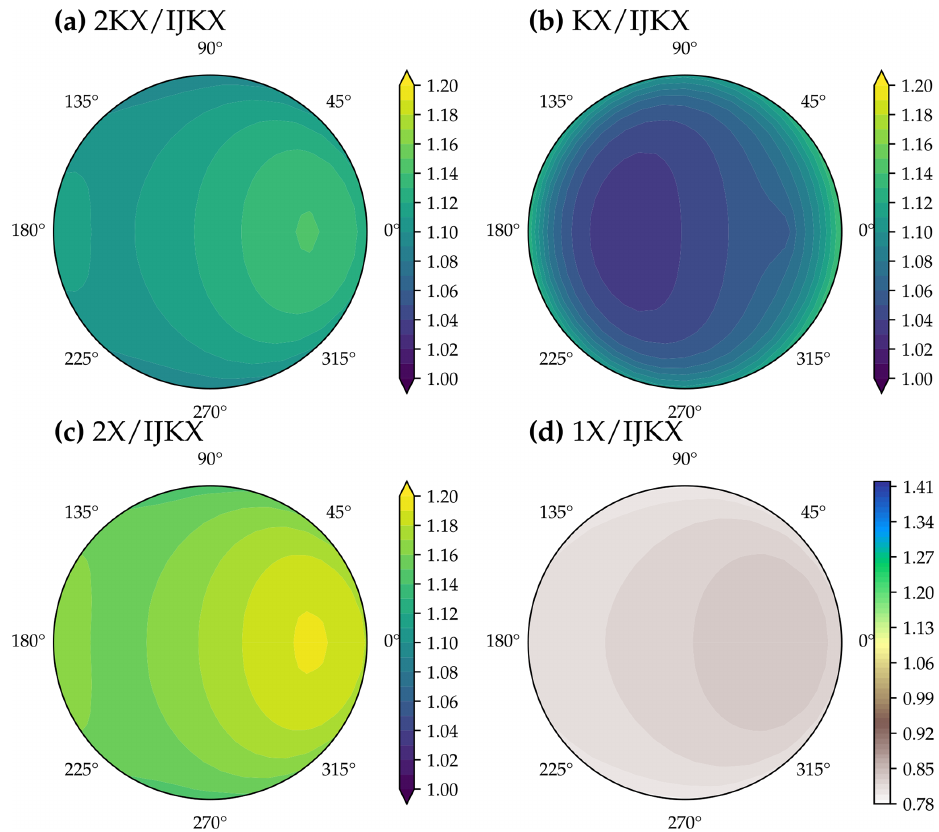
Figure 10. Difference between five different canopy complexity levels in modeled solar-induced chlorophyll fluorescence (SIF) at different viewing zenith angle and relative azimuth angle. The color indicates SIF at 740nm of a tested canopy complexity level relative to IJKX. The model simulations were run with a profile of vertical leaf photosynthetic capacity using observed weather drivers at 16:00–16:30 of day 177 in the year 2019 at a flux tower at Ozark, Missouri, USA